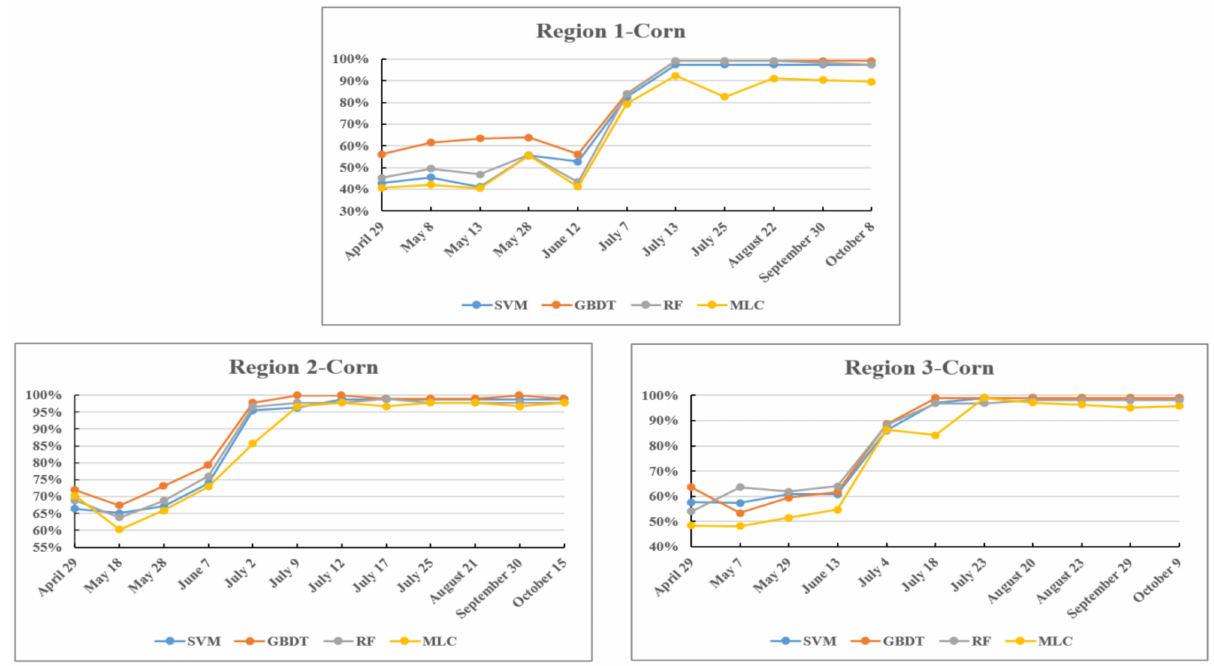
Figure 8. The recognition accuracy of corn in different periods in the three study